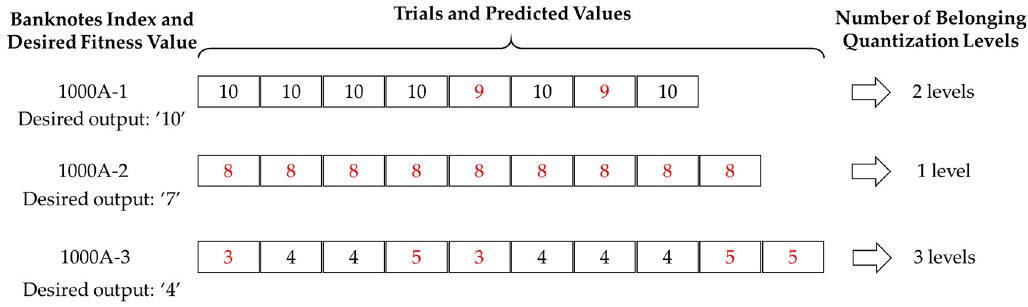
Figure 15. Examples of input banknotes with desired fitness values and their trials with predicted fitness values.